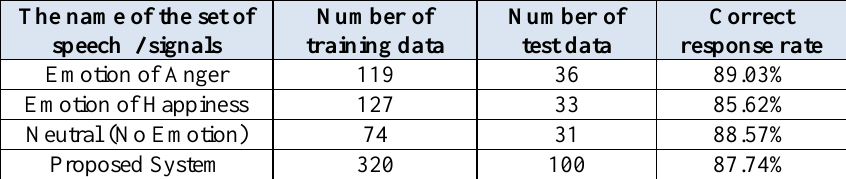
Table 1. Results of the Proposed Algorithm for the Created Database The name of the set